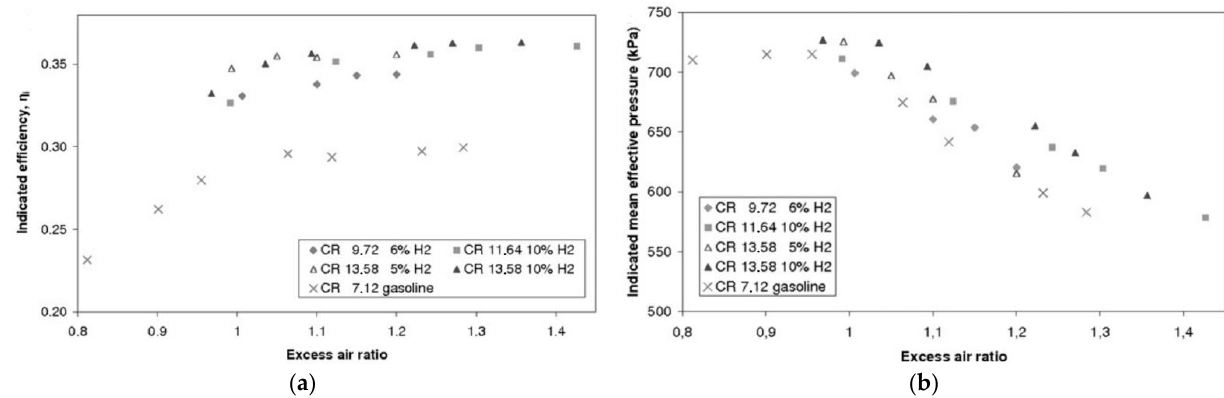
Figure 2. Engine operating characteristics at different compression ratios and hydrogen doping ratios. ( a ) on indicated efficiency; ( b ) on indicated mean effective pressure.